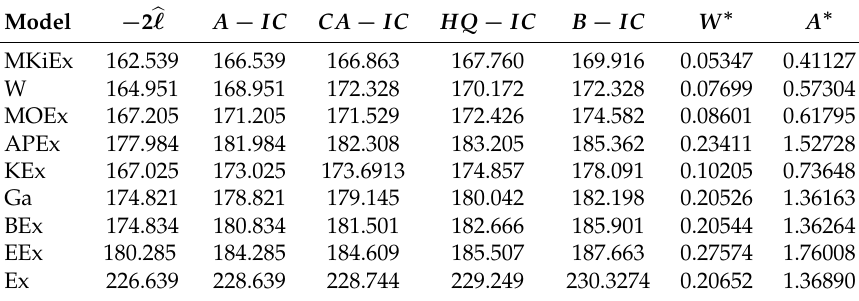
Table 6. Numerical values of the analytical measures for data set II. Model